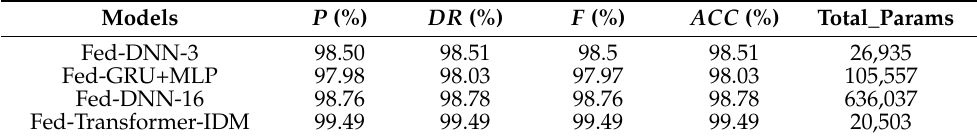
Table 8. The values of evaluation metrics for different global